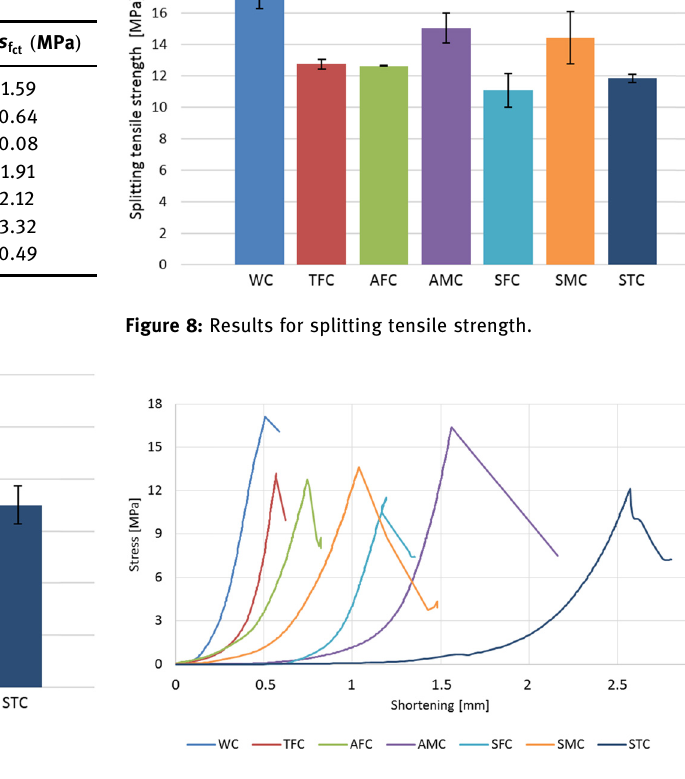
Figure 9: Example courses for splitting tensile